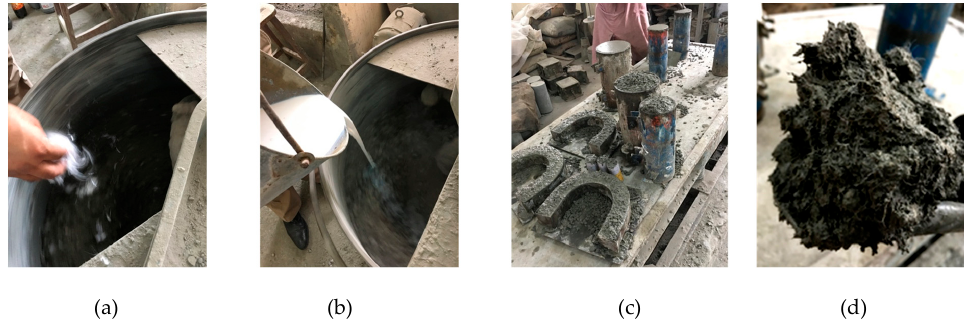
Figure 3. Various steps involved in concrete mixing: ( a ) addition of polypropylene fibers during dry mixing; ( b ) inclusion of liquid-based SBR latex; ( c ) vibration after casting; and ( d ) fibrous concrete after mixing.